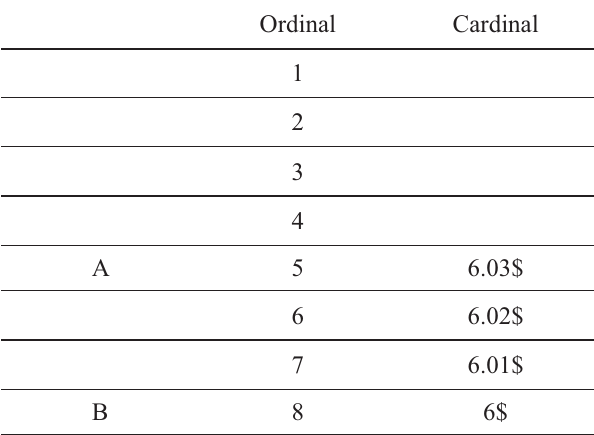
Table B.3. Ordinal versus cardinal: comparing the price of one commodity Ordinal